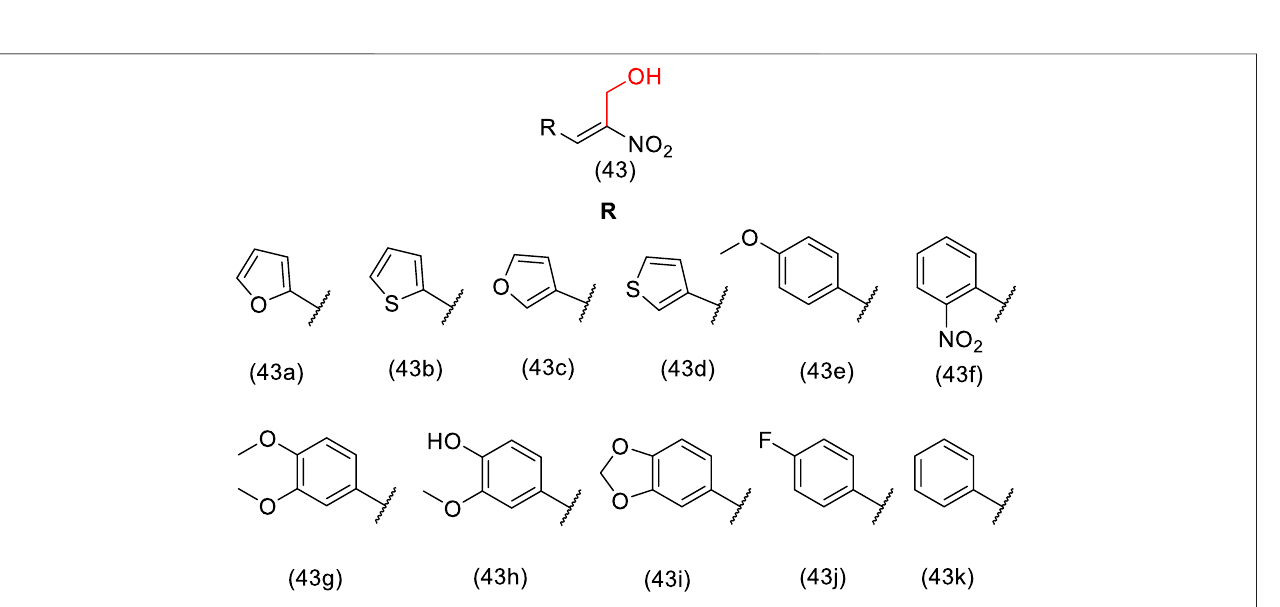
Frontiers in Chemistry |